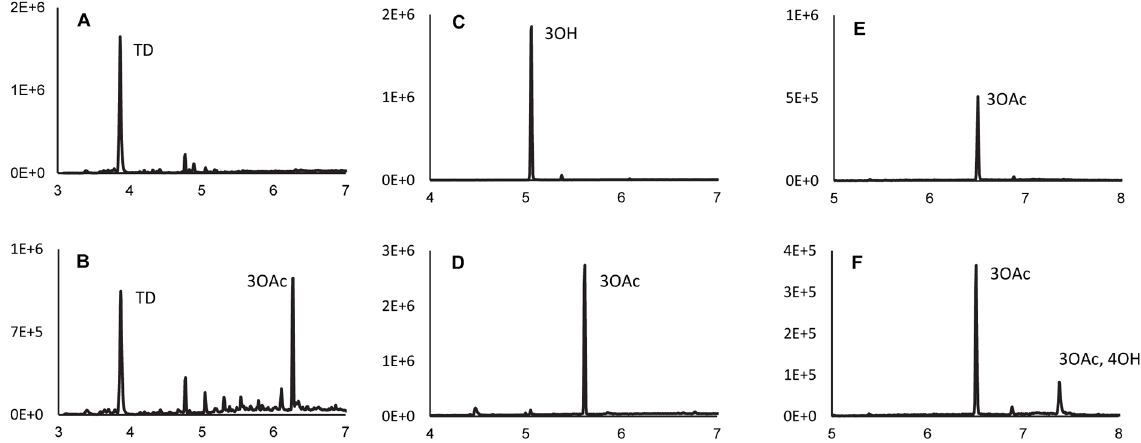
Fig 6. Total ion chromatograms from GC-MS analysis of cultures from heterologous expression of TRI genes from Beauveriabassiana strain ARSEF 2860. ( A) wild-type Fusarium verticillioides grown on YEPD medium containing trichodiene (TD); ( B ) F . verticillioides expressing the B . bassiana TRI4 grown on YEPD medium containing trichodiene; ( C ) ayt1 mutant of Saccharomyces cerevisiae grown on YG medium containing isotrichodermol (3-hydroxy EPT, 3OH); ( D ) ayt1 mutant of S . cerevisiae expressing the B . bassiana TRI101 grown on YG medium containing isotrichodermol; ( E ) wild-type F . verticillioides grown on YEPD medium containing isotrichodermin (3- O -acetylEPT, 3OAc); ( F ) F . verticillioides expressing the B . bassiana TRI22 grown on YEPD medium containing isotrichodermin. In each chromatogram, the Y-axis is total ion abundance, and the X-axis is time in minutes. The peak labeled 3OAc,4OH indicates 4-hydroxy isotrichodermin (3- O -acetyl- 4-hydroxy EPT).